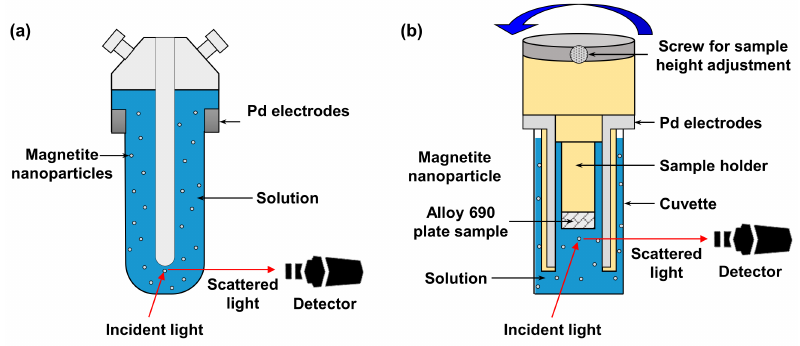
Figure 4. Schematic diagram of ( a ) particle zeta potential kit and ( b ) surface zeta potential